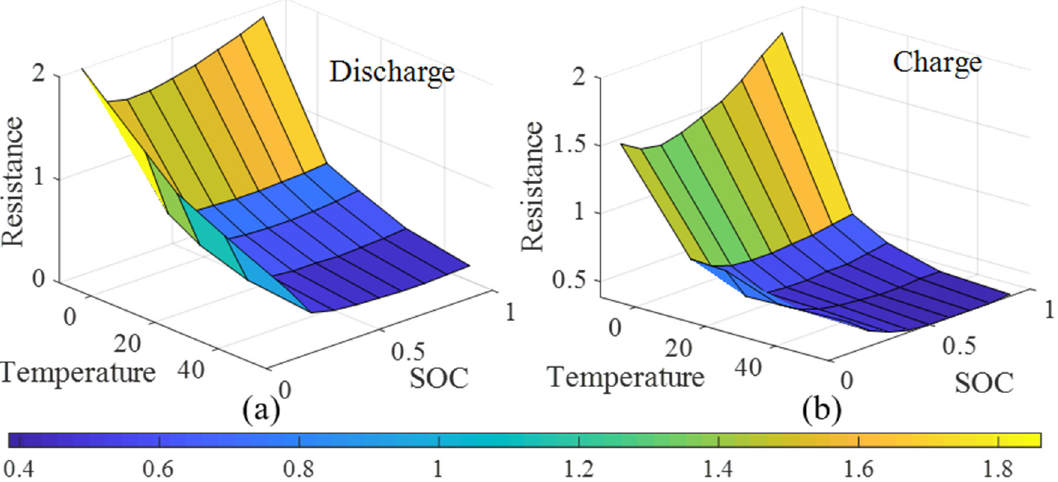
7 of 25 Figure 3. Efficiency maps of the front/rear motors and generator. ( a ) Front motor; ( b ) Rear motor; ( c ) Generator motor. 2.5. Battery Model